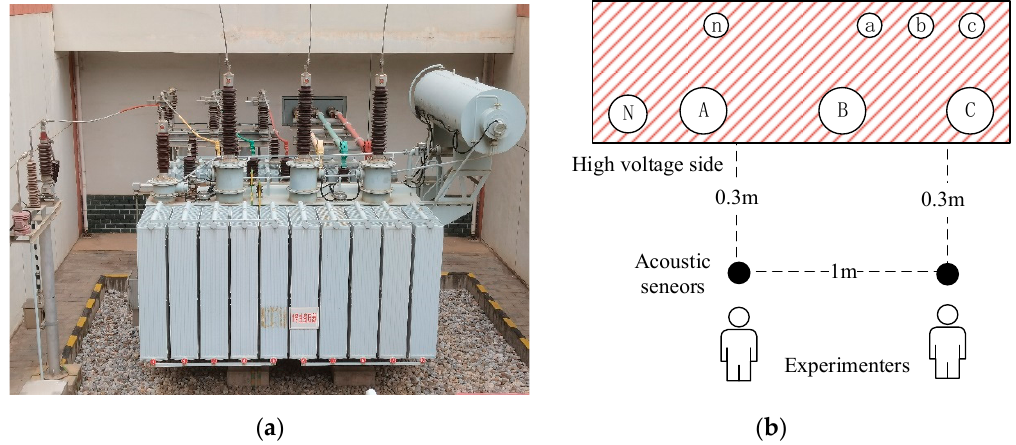
Figure 10. Physical diagram and experiment schematic diagram of the transformer; (( a ): power transformer, three phases, 50 MVA, 50 Hz; ( b ): experiment schematic diagram.).